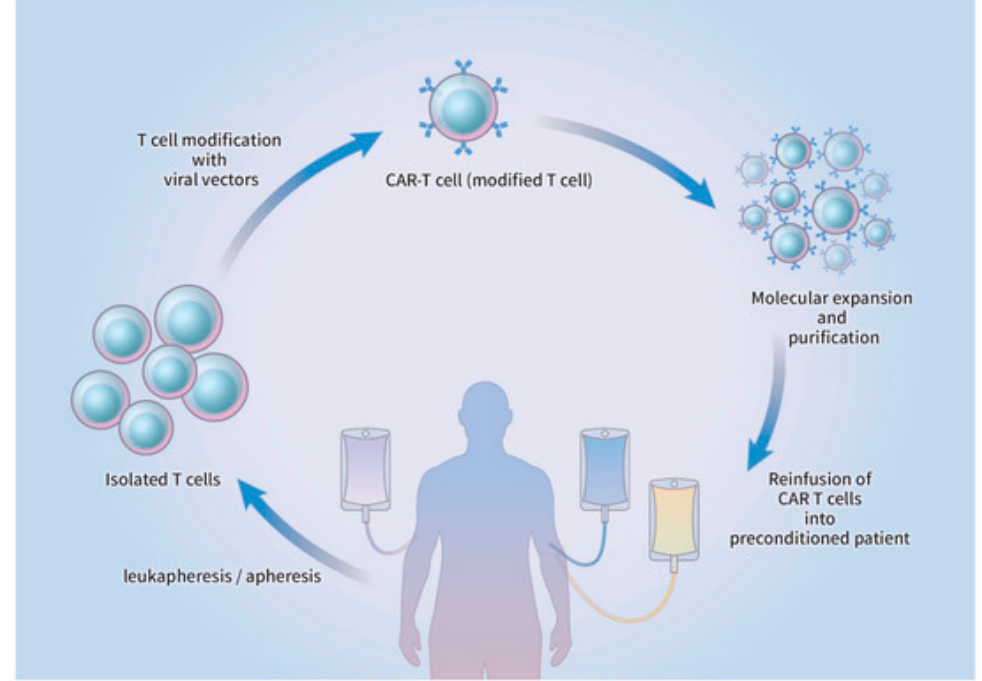
Figure 2. A graphic representation of chimeric antigen receptor (CAR)-T cell production. After being harvested from the peripheral circulation, leukapheresis and subsequent apheresis are used to isolate T cells. The prepared T cells undergo transduction by viral or non-viral vectors and are genetically altered to express chimeric antigen receptors. Before reinfusion, CAR-T cells are subjected to ex vivo expansion and puri fi cation and are reinfused into the lymphodepleted patient [25]. This treatment modality has not yet been proven to have the same efficacy in solid tumors shown in hematologic malignancies [44,45]. Only a small proportion of cancer-specific anti- gens is available in the clinical setting of solid neoplasms; therefore, CAR-T cell therapy is less likely to be successful against tumor cells. Identifying new targets and biomarkers is a priority for ongoing and future CAR-T immunotherapy treatments for EC patients.